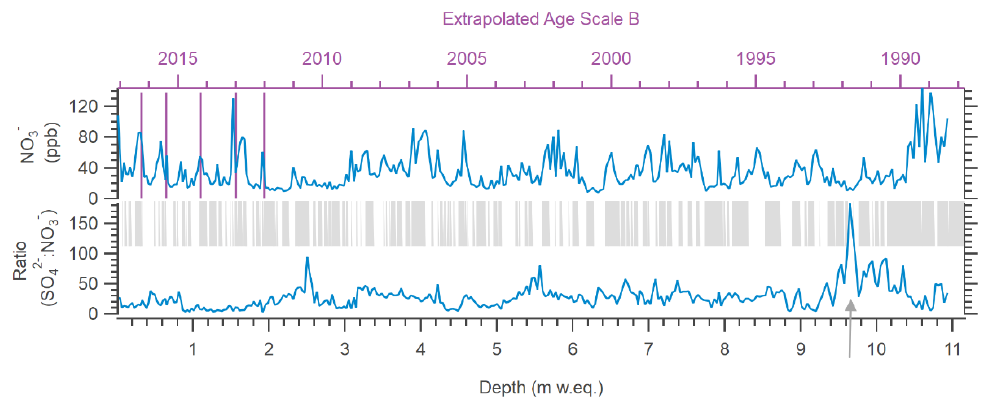
Figure 8. NO 3 − profile with manually picked markers (vertical purple lines) and the fully extrapolated age scale B (upper x -axis) in the context of melt layers (vertical grey bars) and SO 42 − :NO 3 − ratio in the lower panel; a grey vertical arrow indicates the period of Pinatubo eruption.